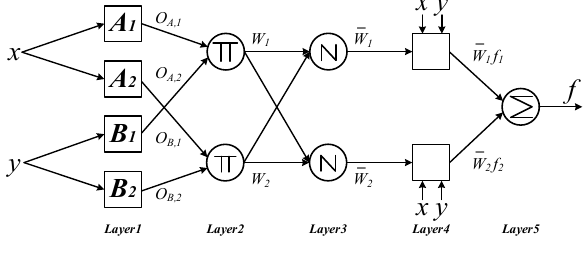
Fig. 3. The structure of